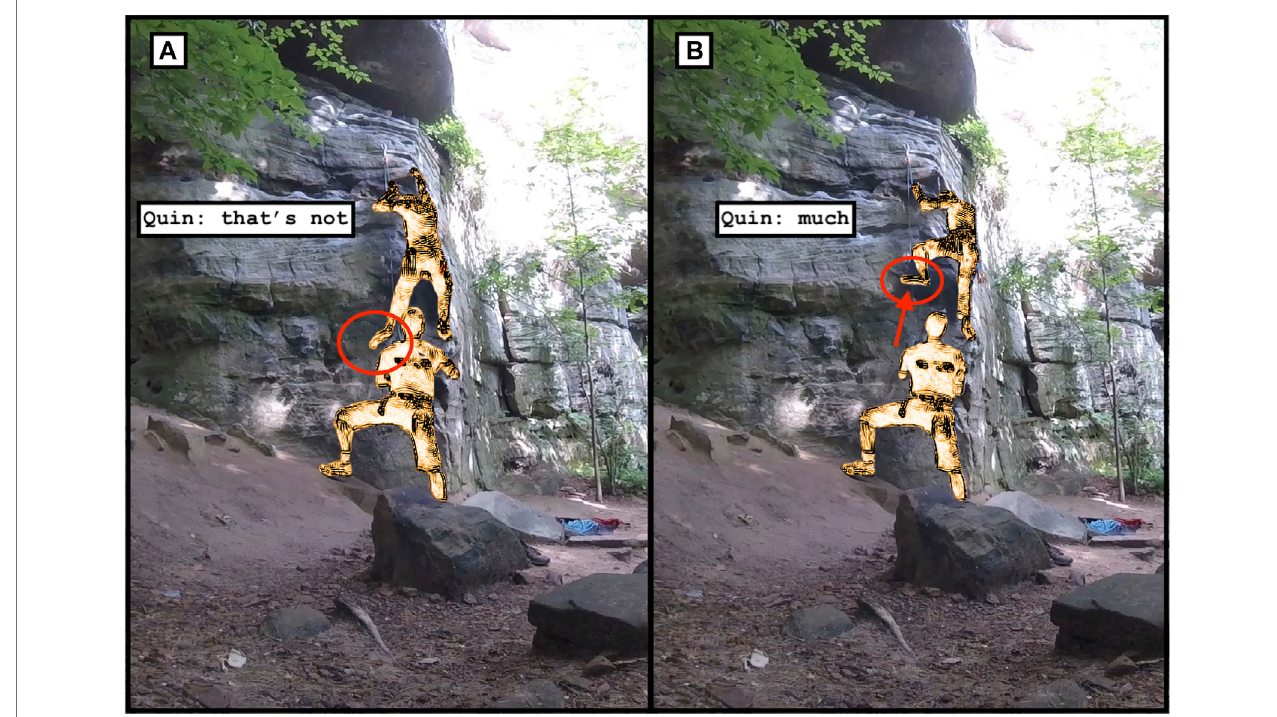
FIGURE1| Quinbeginstheclausebeforeliftinghislegandfoot,andcontinuesitwhenhislegreacheshipheight(whenhisabdomenmustengagemorestronglyto keep lifting the leg and